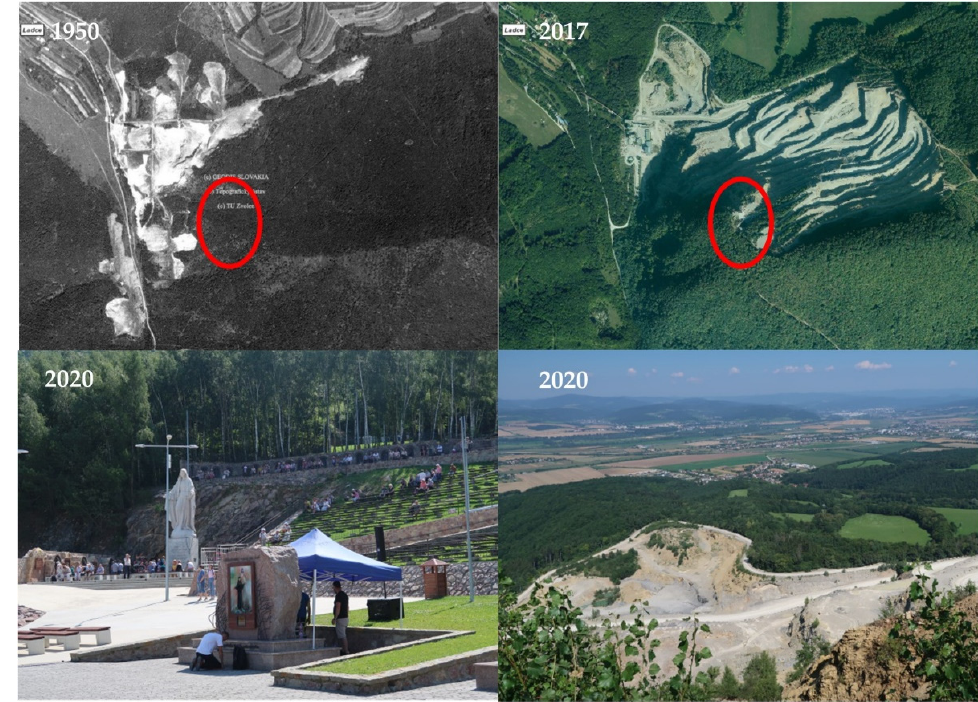
Figure 5. Visual interpretation of the Butkov (The Rock Sanctuary of Divine Mercy on Butkov) site.